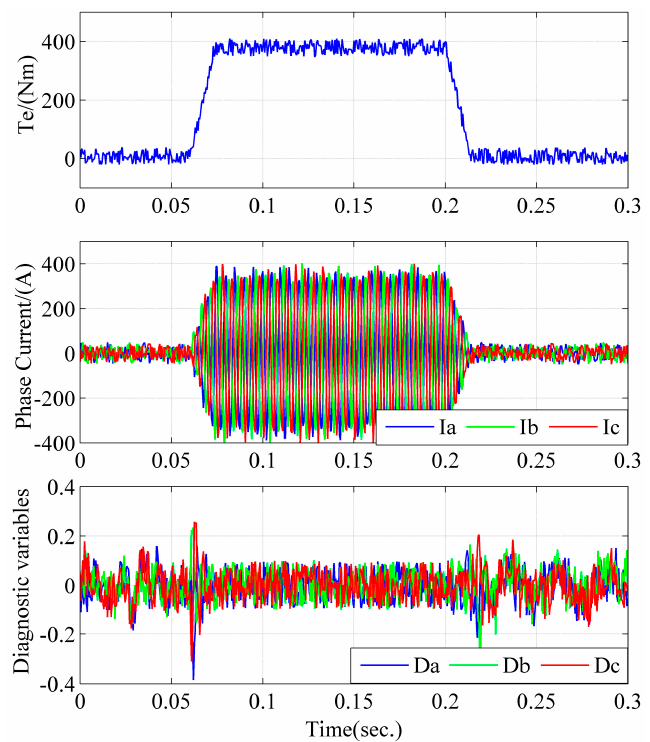
Figure 15. Experimental results under a sudden change of load torque conditions.